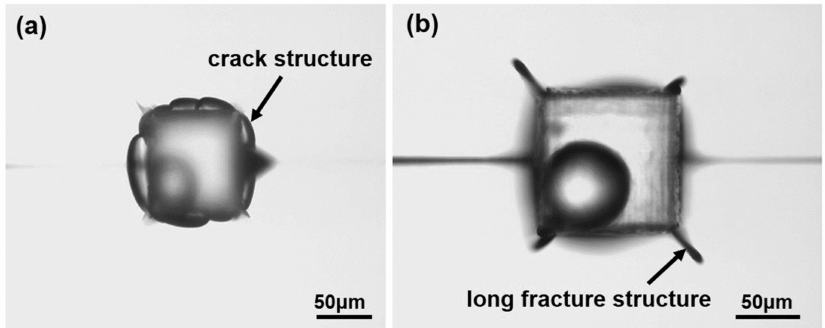
Figure 4. Microcavity nested structure with cracks. ( a ) crack structure with random shape; ( b ) long fracture structures at the four sharp angles.